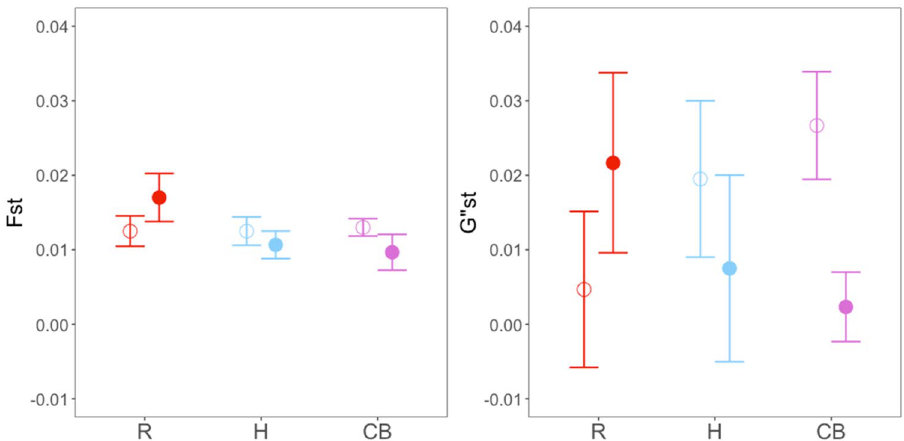
Figure 4. Mean and standard error for genetic differentiation estimators (Fst and G”st) calculated between both sides of the putative barrier within each plot. Means are computed for plots belonging to each type of putative barrier (filled dots; R, H, CB) and compared to their controls (empty